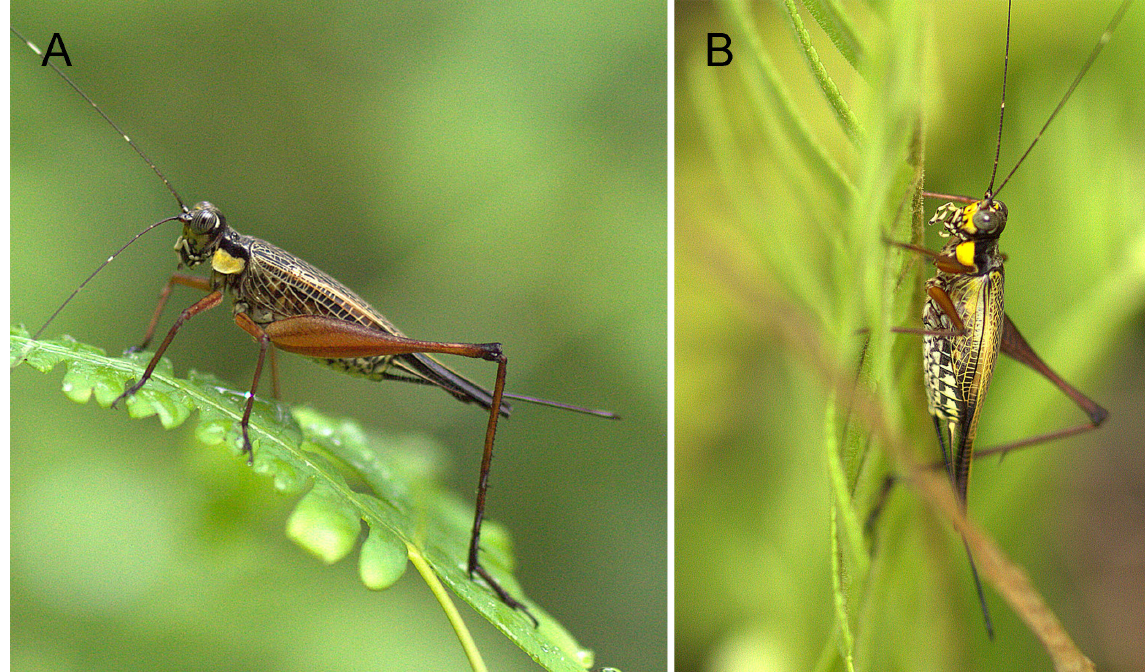
Fig. 21. Nisitrus hyalinus ?, adult ♀♀ in their natural environment. Photograph source and credits: Marcel